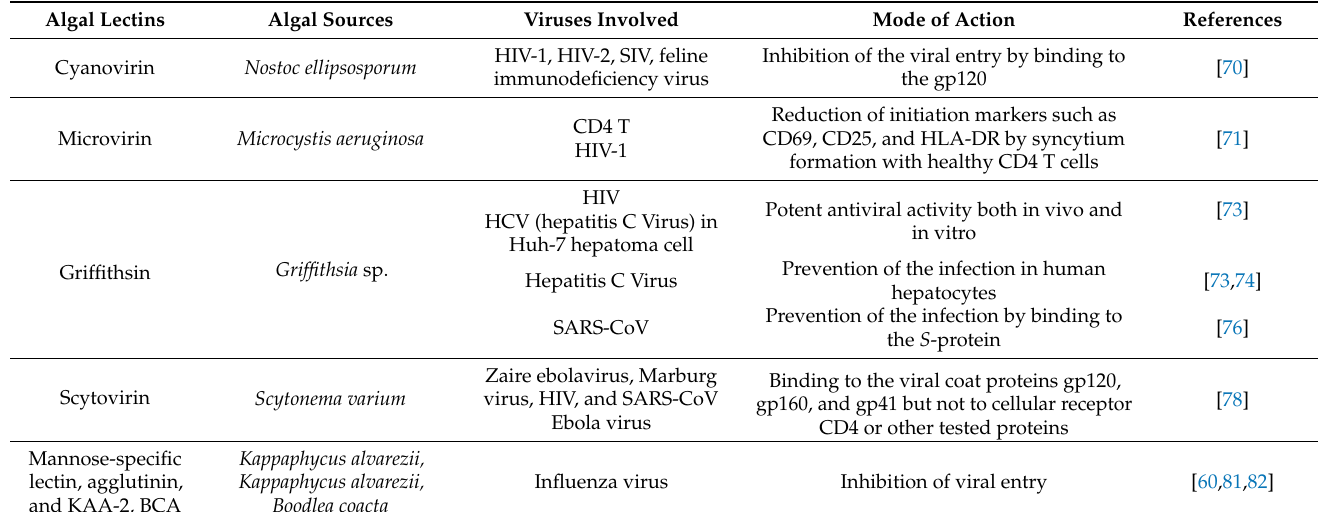
Table 2. Marine algae-derived lectins with promising antiviral properties and their mode of